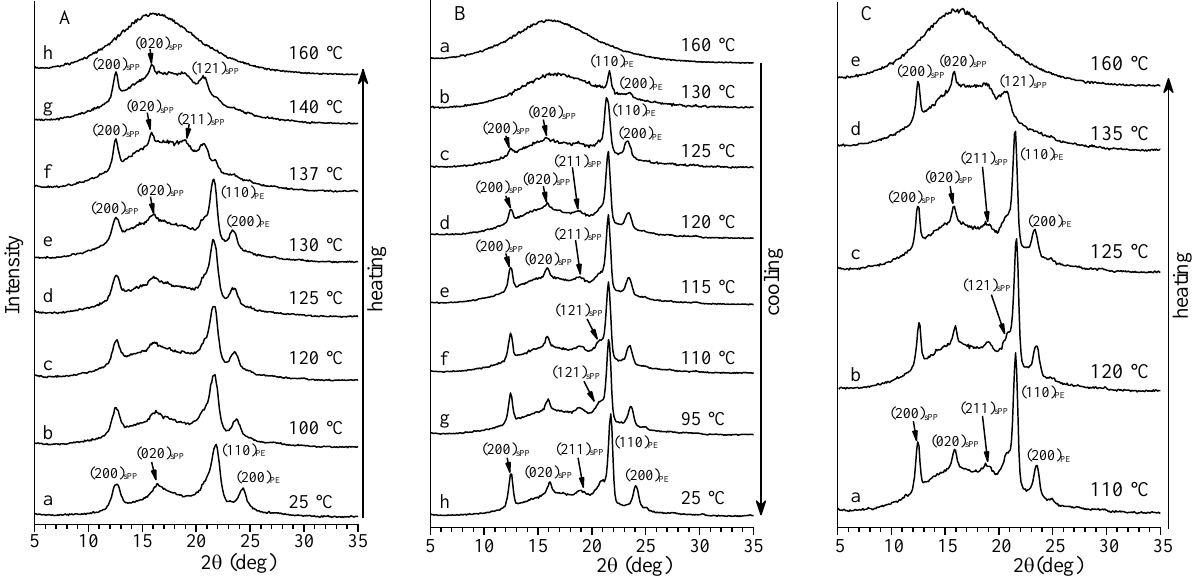
Figure 4. X-ray powder diffraction profiles of the sample PE- b -sPP-2 with f sPP = 75% recorded at different temperatures during first heating (a-h) of the as-prepared sample up to the melt ( A ), during cooling (a-h) from the melt down to room temperature ( B ), and during successive heating (a-e) of the melt-crystallized sample up to the melt ( C ). The (200) sPP , (020) sPP , (211) sPP and (121) sPP reflections of form I of sPP at 2 θ = 12°, 16°, 18.8° and 20.7°, respectively, and the (110) PE and (200) PE reflections of the orthorhombic form of PE at 2 θ = 21° and 24°, respectively, are indicated.